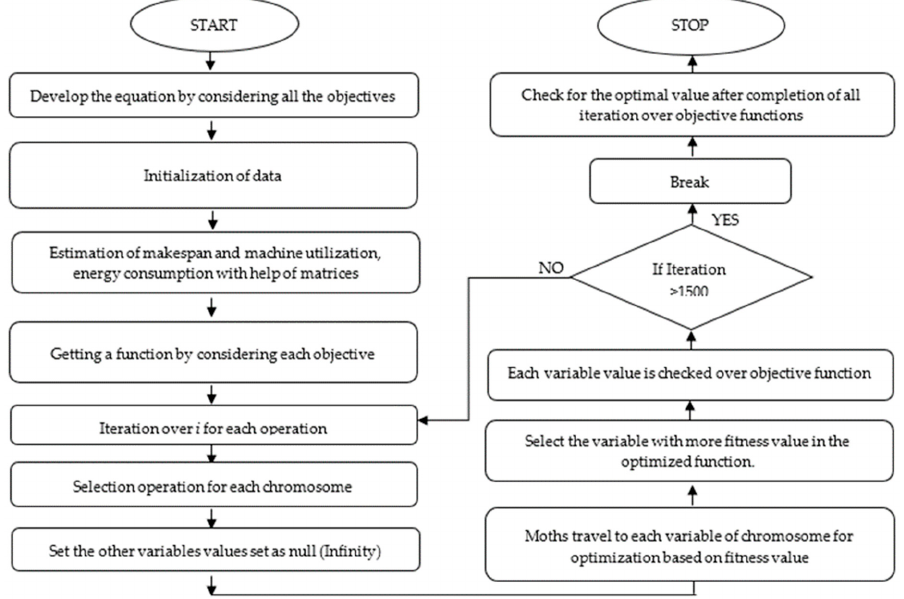
Figure 7. Flowchart of the proposed HMFO. Table 5. Initialization of parameters for proposed solution algorithm.